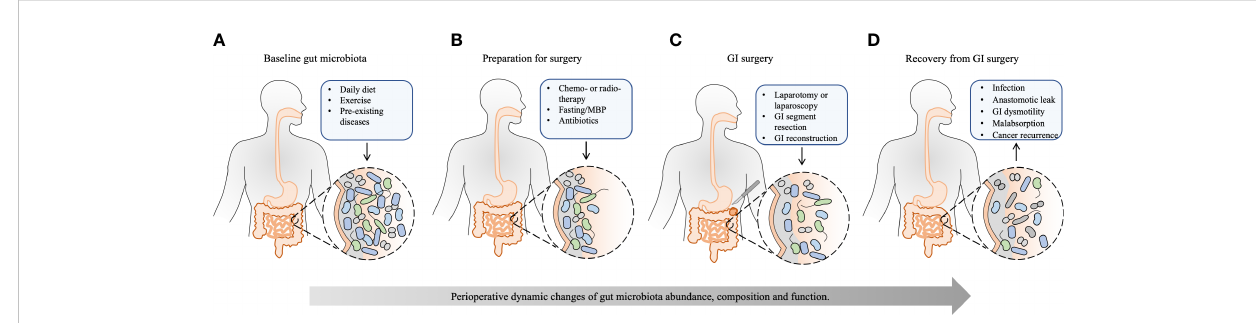
FIGURE 1 The effect of perioperative events on the gut microbiota and recovery from GI surgery. Except for the basic condition of the host, the whole process of GI surgery, from preoperative preparation to recovery from GI surgery, has a signi fi cant and accumulated effect on the gut microbiota. (A) The baseline gut microbiota is dependent on different daily diets, exercise, and pre-existing diseases, such as obesity, type 2 diabetes mellitus, cardio- metabolic diseases, non-alcoholic fatty liver disease, in fl ammatory bowel disease, and GI cancer. (B) Neoadjuvant chemo- or radiotherapy reduces tumor size and kills metastatic cells to facilitate the subsequent tumor removal, which may disrupt gut microbiota. Preoperative bowel preparation, including fasting, MBP, and oral antibiotics, eliminates bulky GI content and reduces the luminal bacterial load, leaving behind certain mucosal bacteria. Besides, prophylactic intravenous antibiotics have a further effect on the composition of gut microbiota. (C) Surgical procedures, including laparotomy or laparoscopy, GI segment resection, and subsequent GI reconstruction, change GI physiology, exert further stress on the gut microbiota, and shift bacterial phenotypes. (D) The healthy recovery from GI surgery is challenged by postoperative complications, such as infection, anastomotic leak, GI dysmotility, malabsorption, and cancer recurrence, which are substantially in fl uenced by perioperative alteration of gut microbiota. Appropriate rebuilding of commensal bacteria may prevent postoperative complications and enhance postoperative recovery. MBP, mechanical bowel preparation; GI,